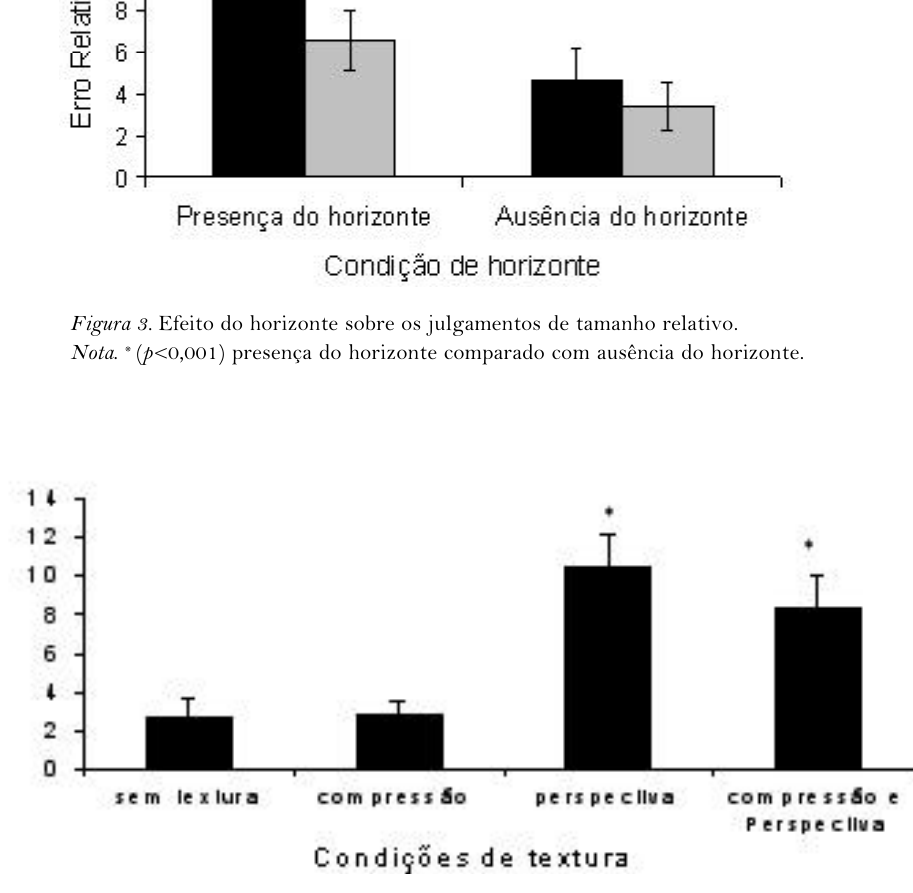
Figura 4 . Efeitos da textura sobre os julgamentos de tamanho relativo. Nota. * ( p< 0,05) gradiente de perspectiva e gradiente de compressão e perspectiva comparados com a condição sem textura e com o gradiente de compressão.